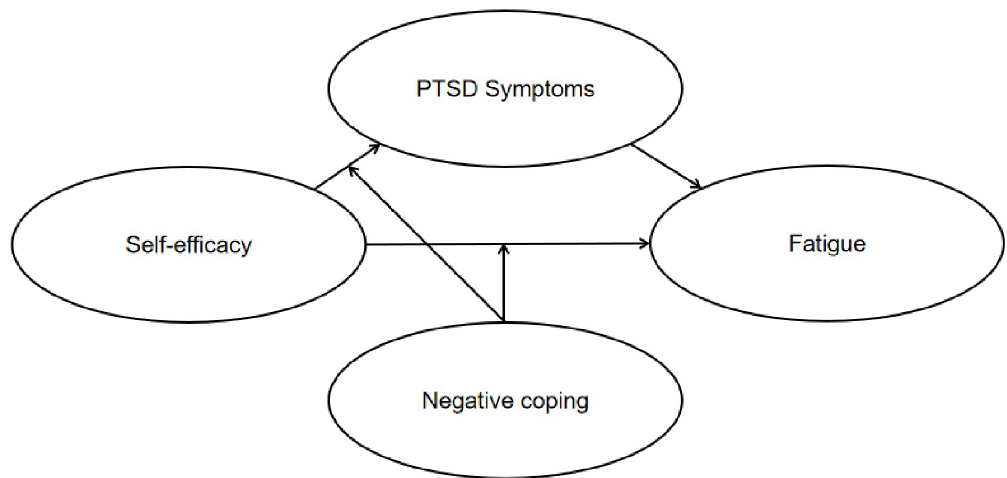
Fig 1. The schematic model of proposed moderated mediation